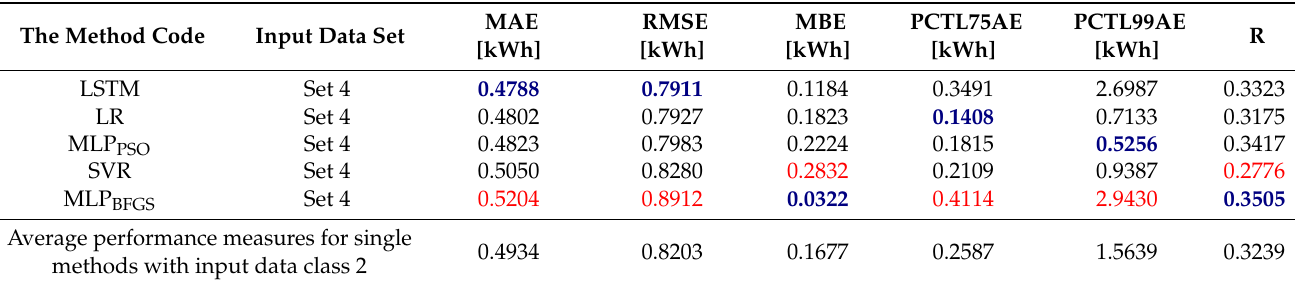
Table 8. Performance measures for single methods with input data class 2.